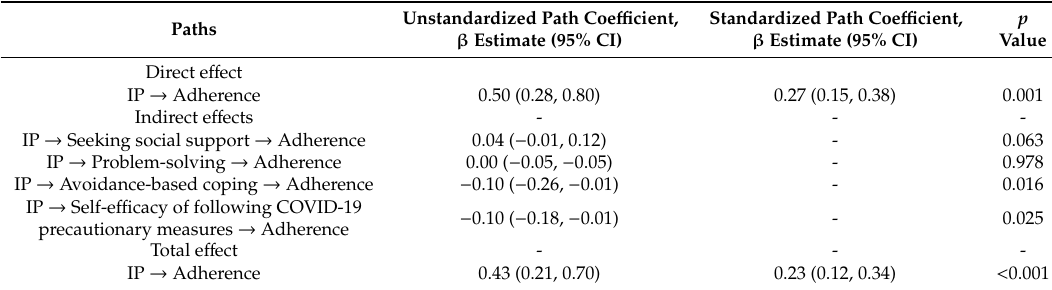
Abbreviations: COVID-19, coronavirus disease 2019; IP, illness perceptions toward